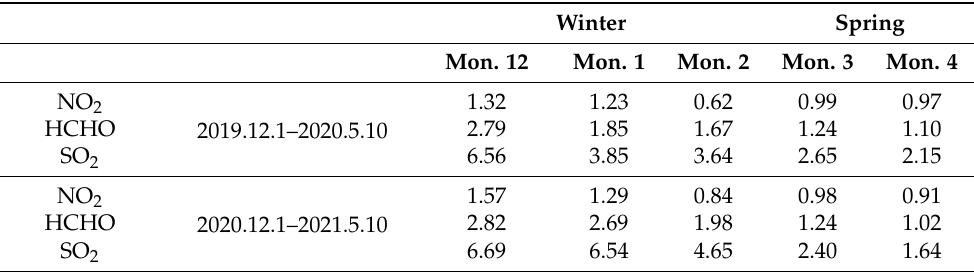
Figure 3. Time series diagram of ( a ) NO 2 , ( b ) HCHO and ( c ) SO 2 VCD S obtained by MAX-DOAS at a 30 ° elevation viewing angle over Huaibei. The observation period is divided into four sections. Table 2. Monthly mean values of NO 2 , HCHO and SO 2 during the observation period (units: 10 16 molecules/cm 2 ).